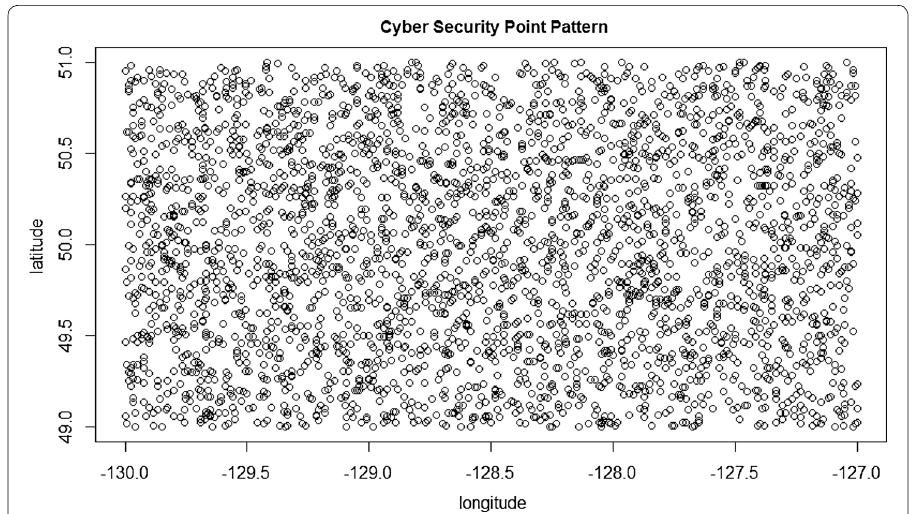
Fig. 2 Crowd with tracking device uniformly distributed in metro